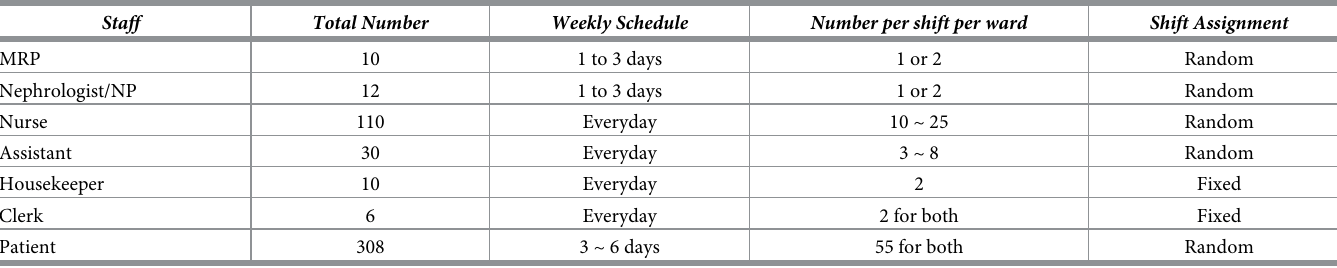
Table 3. Weekly Schedule of healthcare providers and